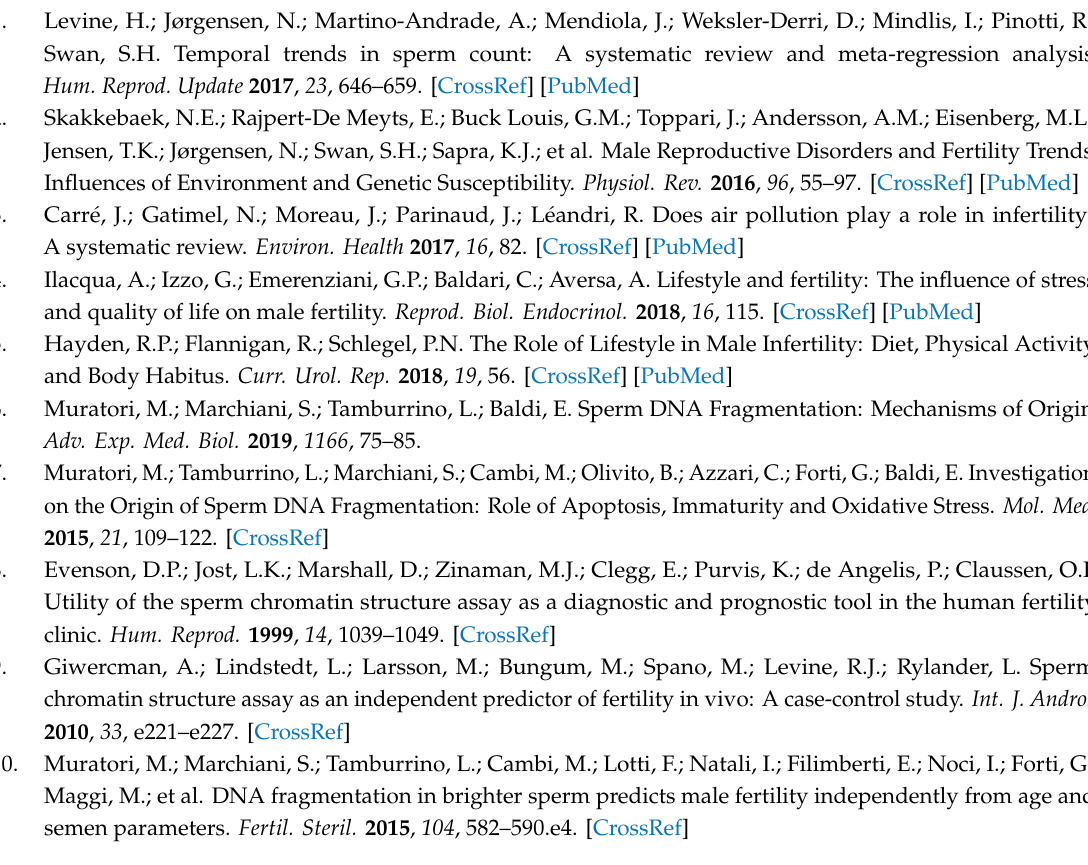
Table S1: Binary logistic regression model with total sDF (Table 1A) or viable sDF (Table 1B) or non-viable sDF (Table 1C), and age, abstinence, sperm number, sperm progressive motility and sperm morphology as introduced